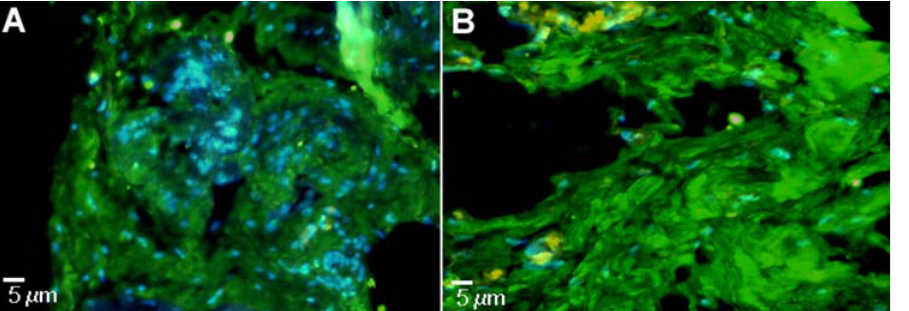
Figure 6. Immunofluorescence for HLA-1 Human FITC (green) (A) Invivoconcave PLGA scaffold. ( B ) In vivo smooth PLGA scaffold. (Calibration Bars=5 m m). Nuclear staining is obtained with DAPI